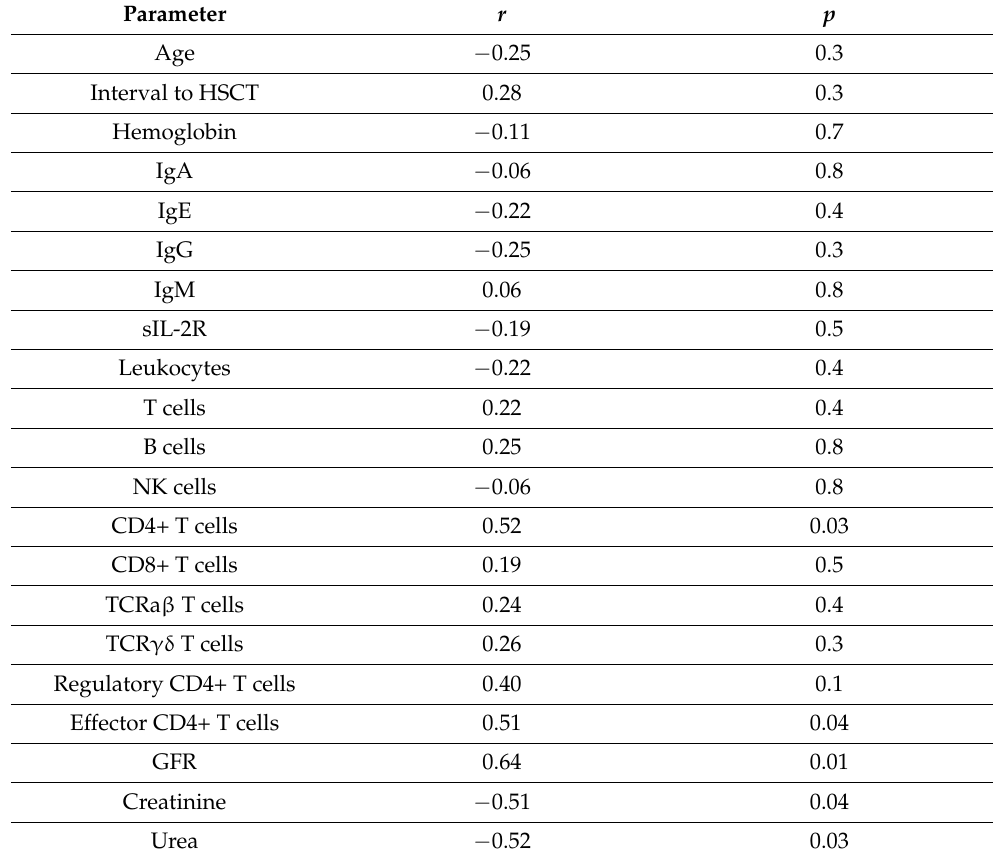
Table A1. Spearman correlation analysis of ELISpot responses towards BKV large T peptides (JPT) in 17 hematopoietic stem cell transplant recipients with BKV-related cystitis.